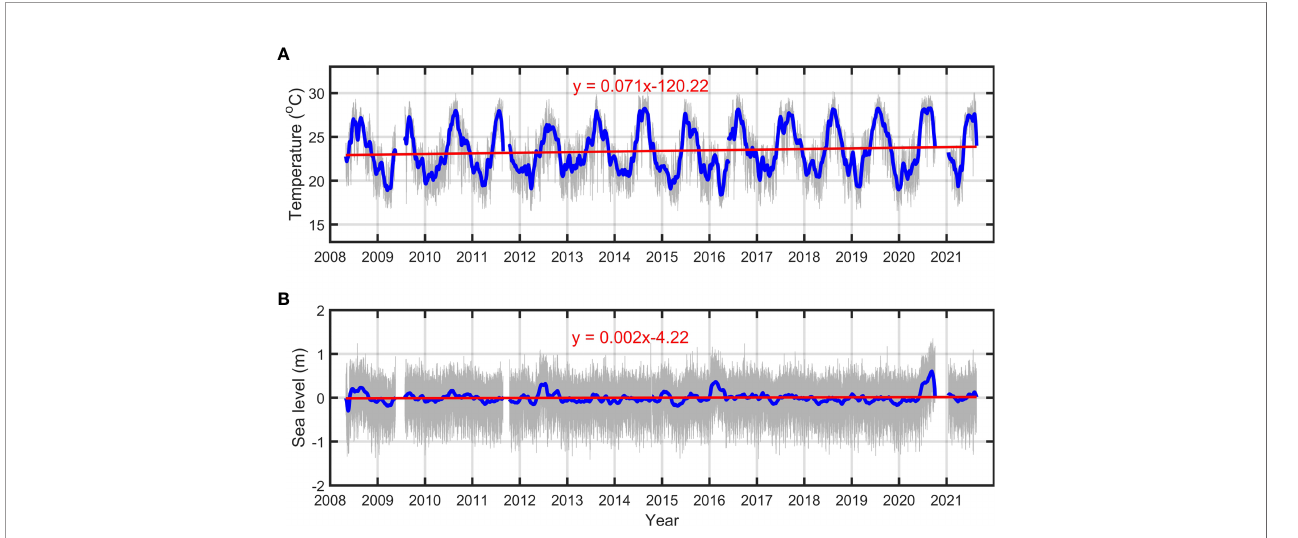
FIGURE 2 | (A) Temperature and (B) sea level measured at the Peng-jia-yu isle during 2008 – 2021. Gray, blue, and red lines represent hourly average and resampled data, 20-day low-pass- fi ltered data, and the linear regression of the data,